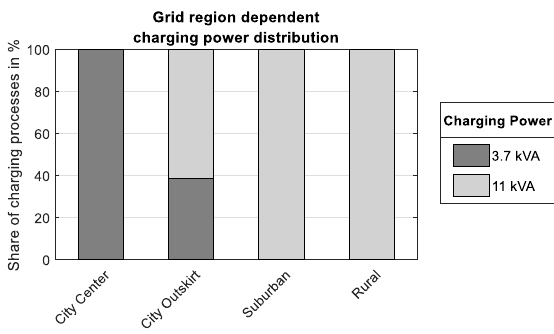
Figure 3. Share of available charging power depending on the grid region.